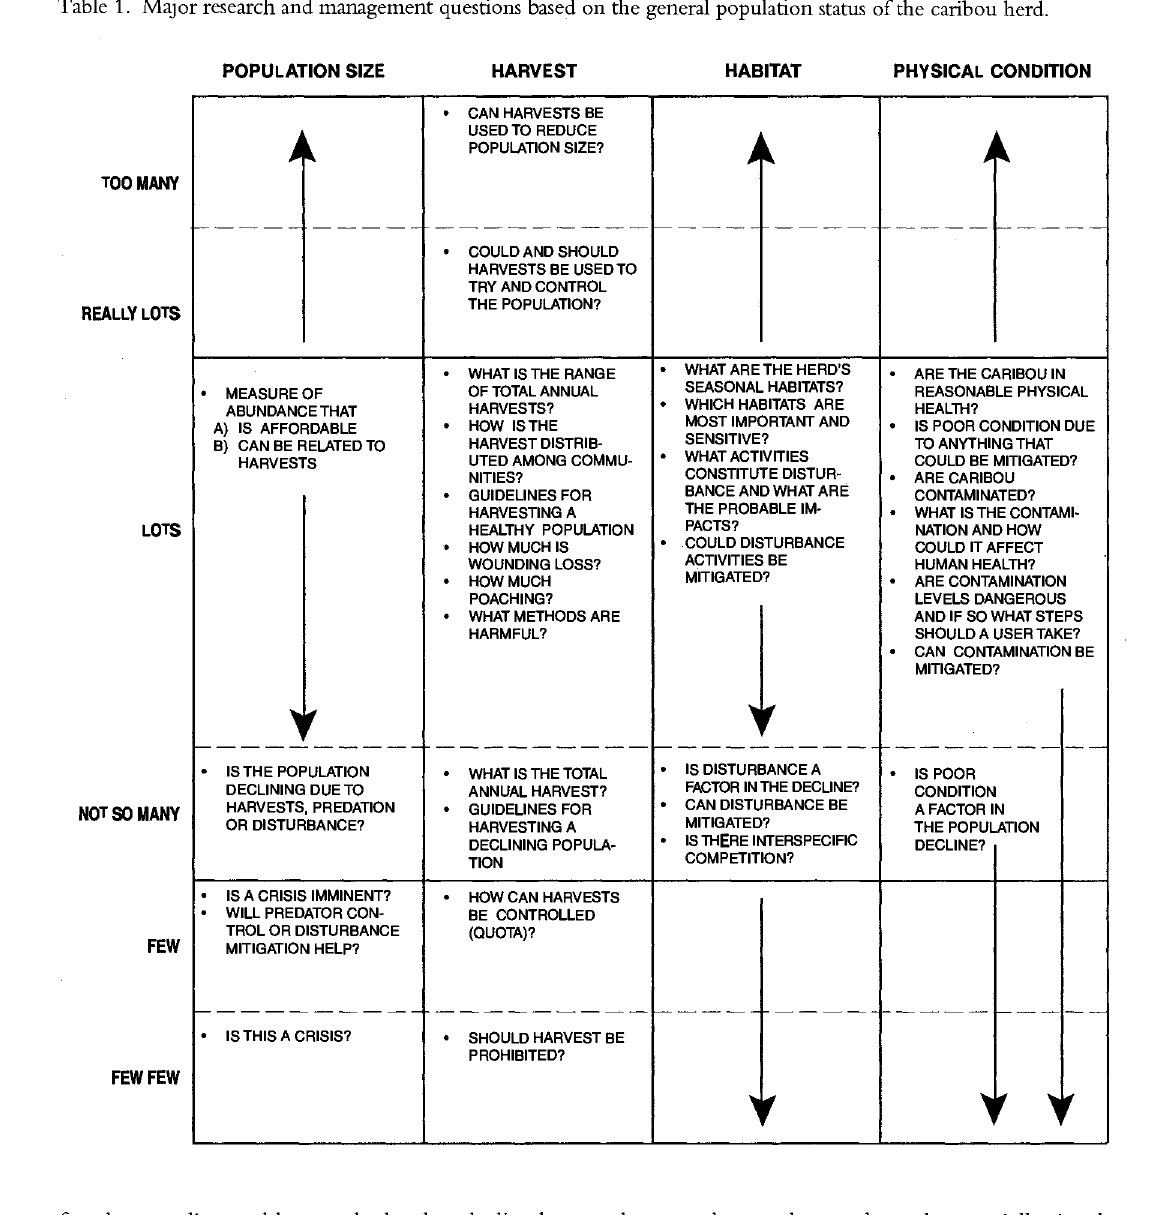
Table 1. Major research and management questions based on the general population status of the caribou herd.